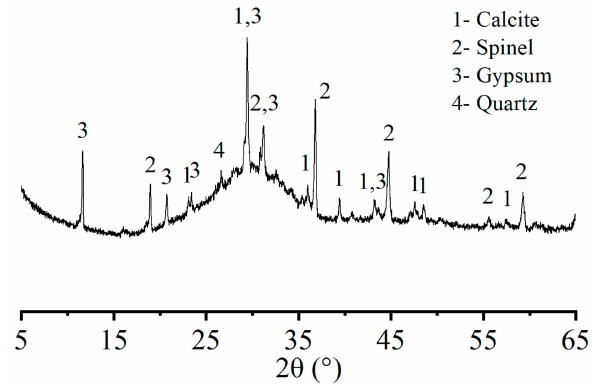
Figure 1. XRD pattern for